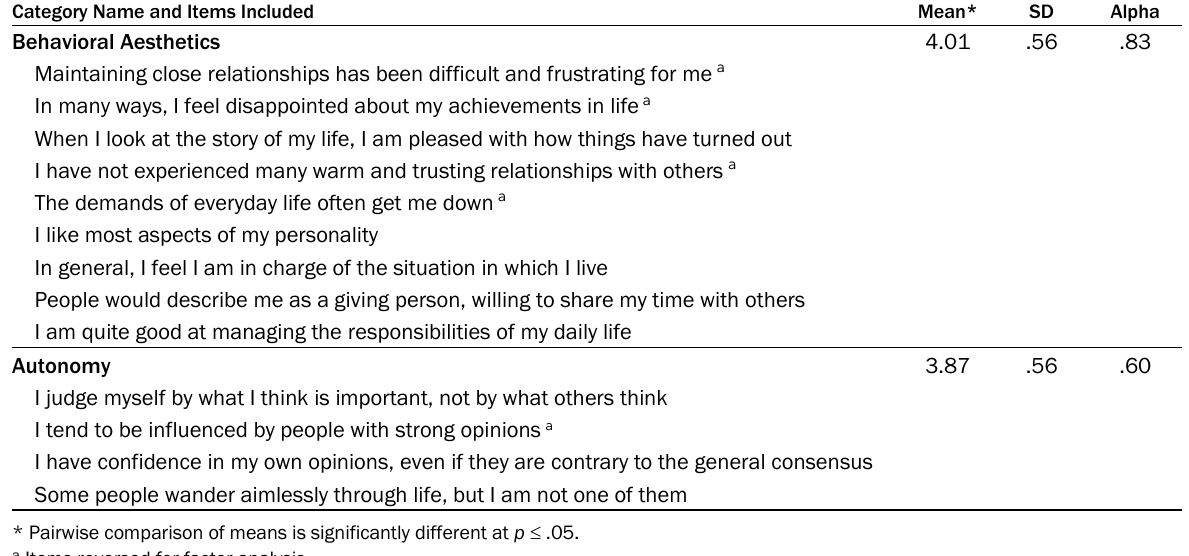
Table 5. Categories of Psychological Well-Being